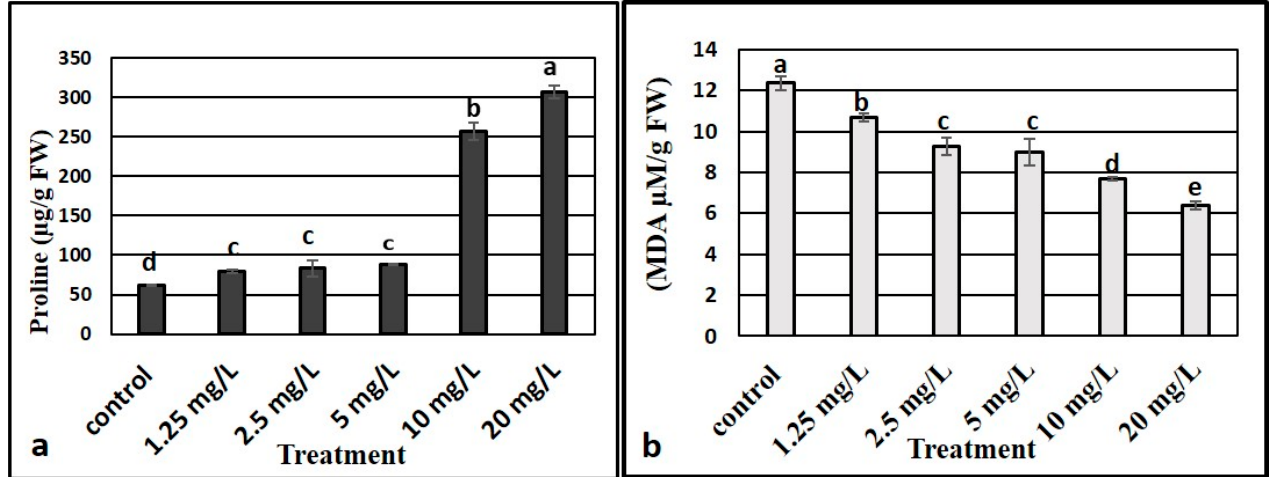
Figure 4. Effect of different concentrations of zinc oxide nanoparticles on proline ( a ) and MDA ( b ) content in Maerua oblongifolia. Means ± SD for each concentration followed by the same letters are not significantly different according to one-way analysis of variance ( p ≤ 0.05).